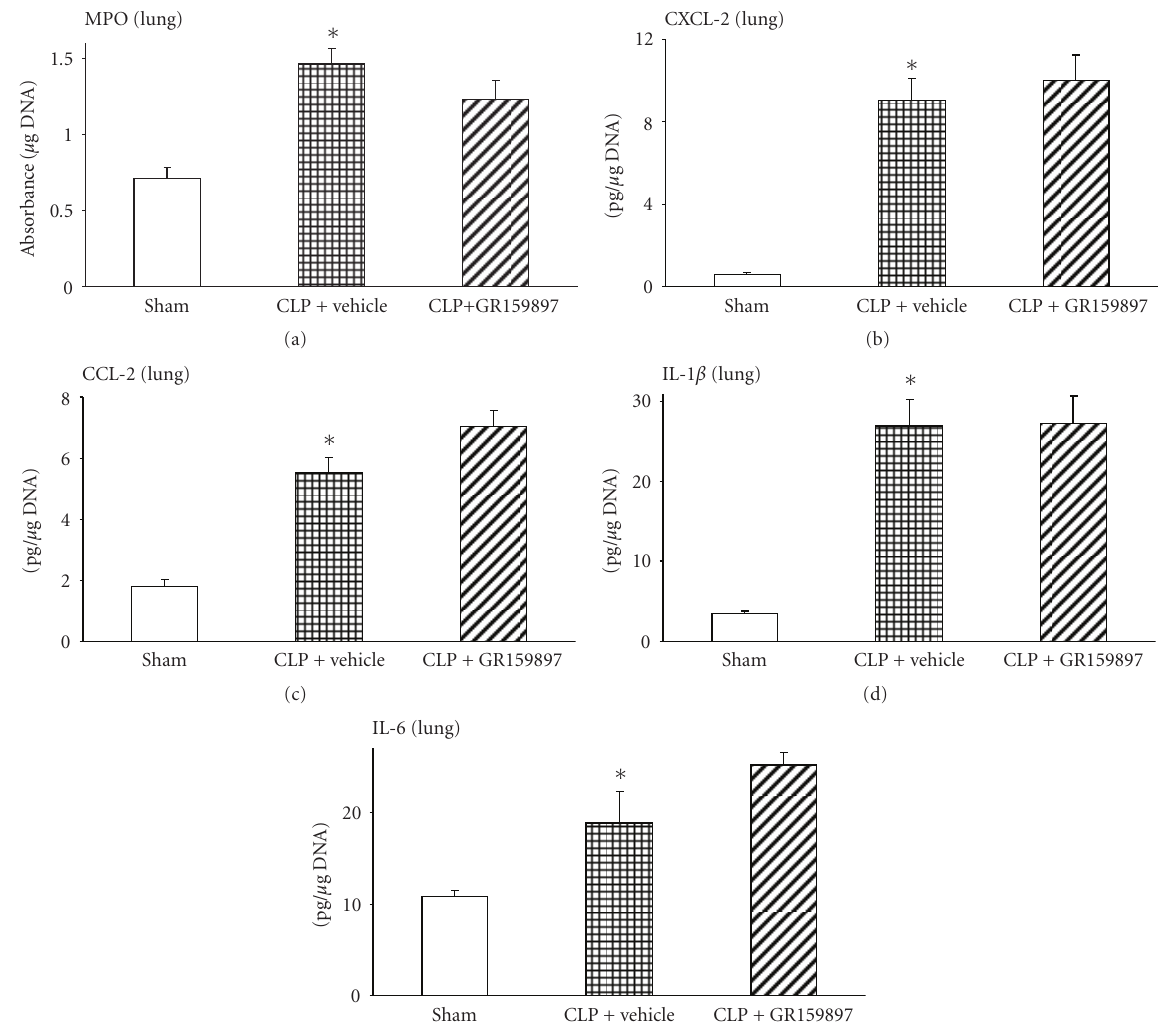
Figure 6: E ff ect of GR159897 administration 1 hour after CLP on lung (a) neutrophil infiltration (MPO), (b) CXCL-2, (c) CCL-2, (d) IL-1 β and (e) IL-6 levels. Results shown are the mean ± S.E.M ( n = 6–9 in each group). “CLP + vehicle” and “CLP + SR140333” represent the groups that received vehicle and SR140333 treatment, respectively, 1 hour after CLP. ∗ P < . 001 when vehicle-treated CLP animals were compared with sham group animals. CLP: cecal ligation and puncture; IL: interleukin; MPO: